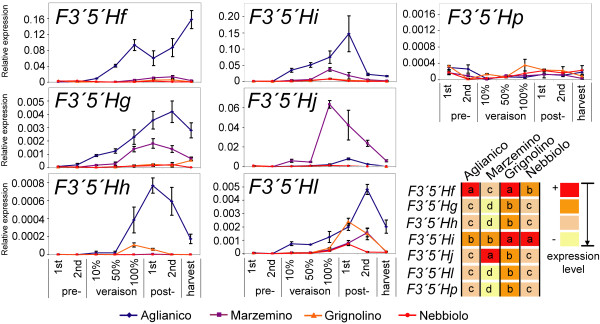
Expression of duplicate F3'5'Hs in berry skin of four cultivars across eight developmental stages. Transcript levels are normalised to the expression of Ubiquitin. Bars indicate standard error of three biological replicates. Stacked panels share the same x-axis, reported below the bottom panel. The panel at the bottom right-hand corner reports significant differences between relative abundance of copy-specific transcripts across all developmental stages, within each cultivar. Colour scale from red to yellow indicates decreasing levels of gene expression, separated by a Student-Newman-Keuls test. Different letters indicate significant differences (P < 0.05).